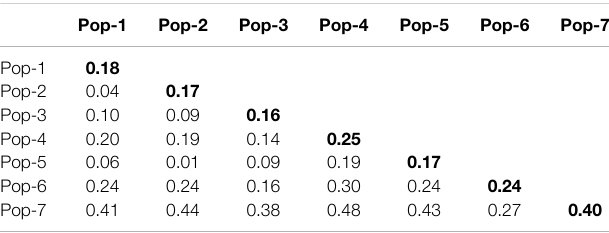
TABLE 4 | Pairwise Nei ’ s standard genetic distance between the seven populations of fi nger millet evaluated using 5,226 SNP markers. A diagonal value is the mean genetic distance of the corresponding populations from the other populations.